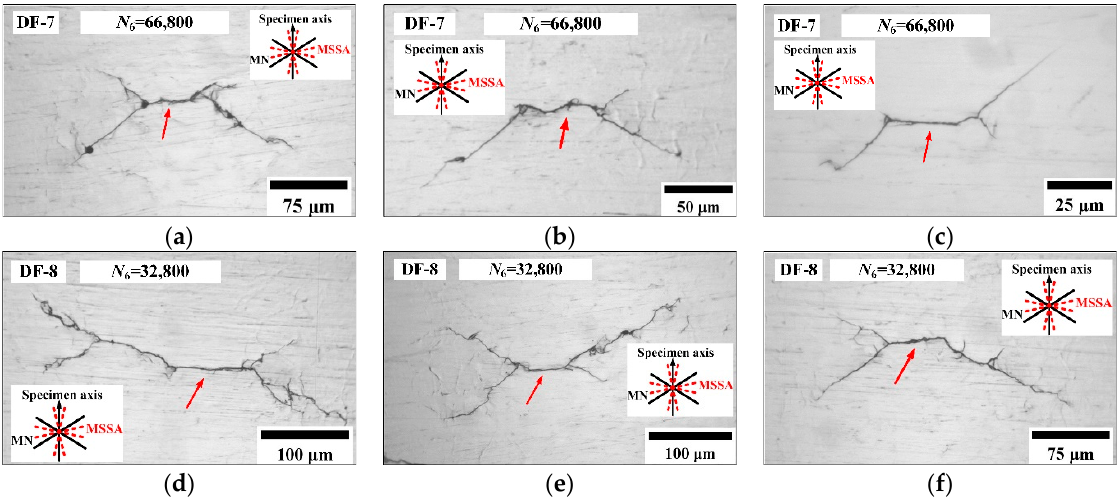
Figure 12. Secondary crack morphologies in specimens DF-7 ( a – c ) and DF-8 ( d – f ).